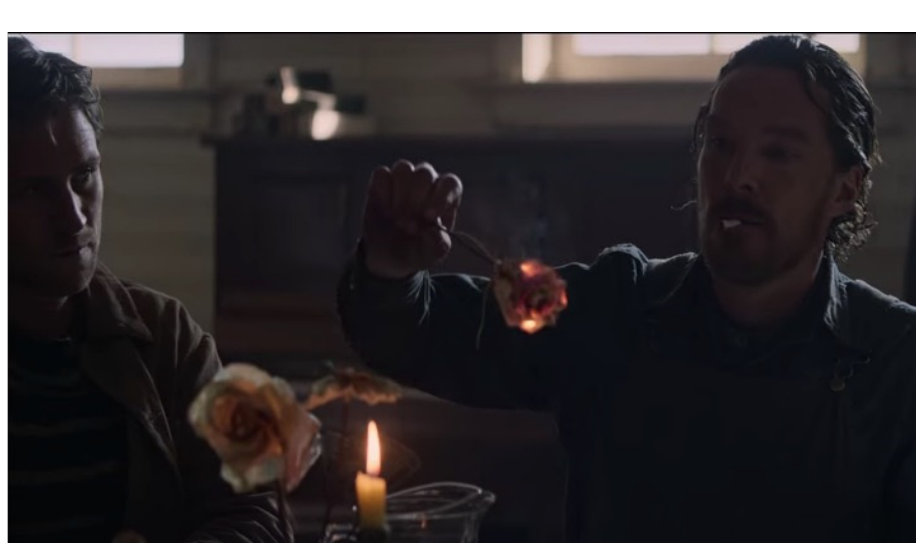
Figure 9. The Power of the Dog . Netflix.